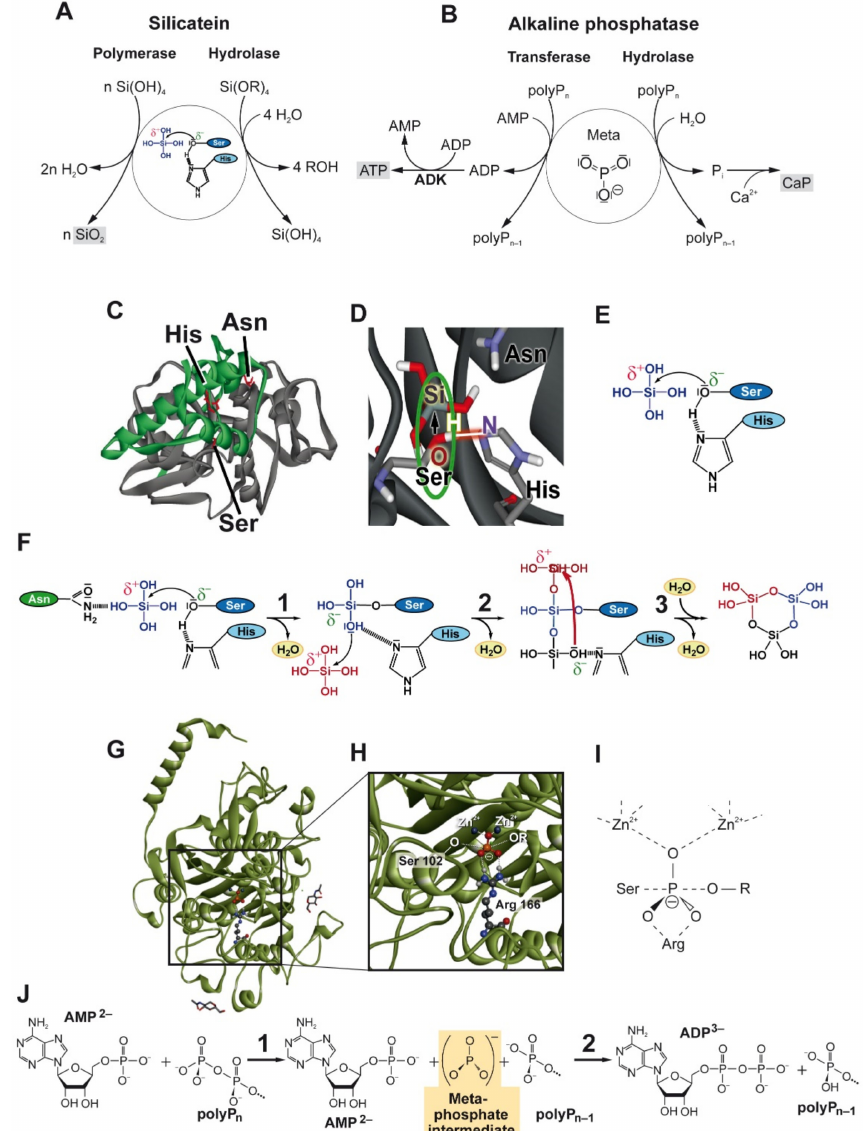
Figure 1. Biocatalytic activities of silicatein and alkaline phosphatase (ALP), the principle enzymes involved silica and calcium phosphate/hydroxyapatite biomineral synthesis. ( A ) Silicatein exhibits both a hydrolase activity (hydrolytic cleavage of Si-O-C bonds, e.g., of tetraalkoxysilane compounds), and silica polymerase activity, mediating the formation of polymeric biosilica from natural monomeric silicic acid precursors. ( B ) ALP can act both as a hydrolase, which degrades polyphosphate (polyP) to monomeric orthophosphate forming calcium phosphate deposits, and as a transferase that transfers a metaphosphate intermediate formed by cleavage of the polymer to AMP. The ADP formed is then used as a substrate by adenylate kinase (ADK). ( C – F ) Reactions proceeding at the catalytic site of silicatein and ( G – J ) of ALP; the reactions numbered are described in the text. ( C ) Computer model of silicatein showing the catalytic triad amino acids His, Ser and Asn (in red). The propeptide sequence of the immature silicatein is given in green. ( D , E ) Proposed mechanism of biosilica formation. The reaction starts by nucleophilic attack of the OH group of a Ser residue at the silicic acid monomer, facilitated by a hydrogen bridge formation to the His imidazole group. ( F ) Subsequent steps of the proposed silicatein mechanism, leading to the formation of a reactive cyclic trisilicic acid species.